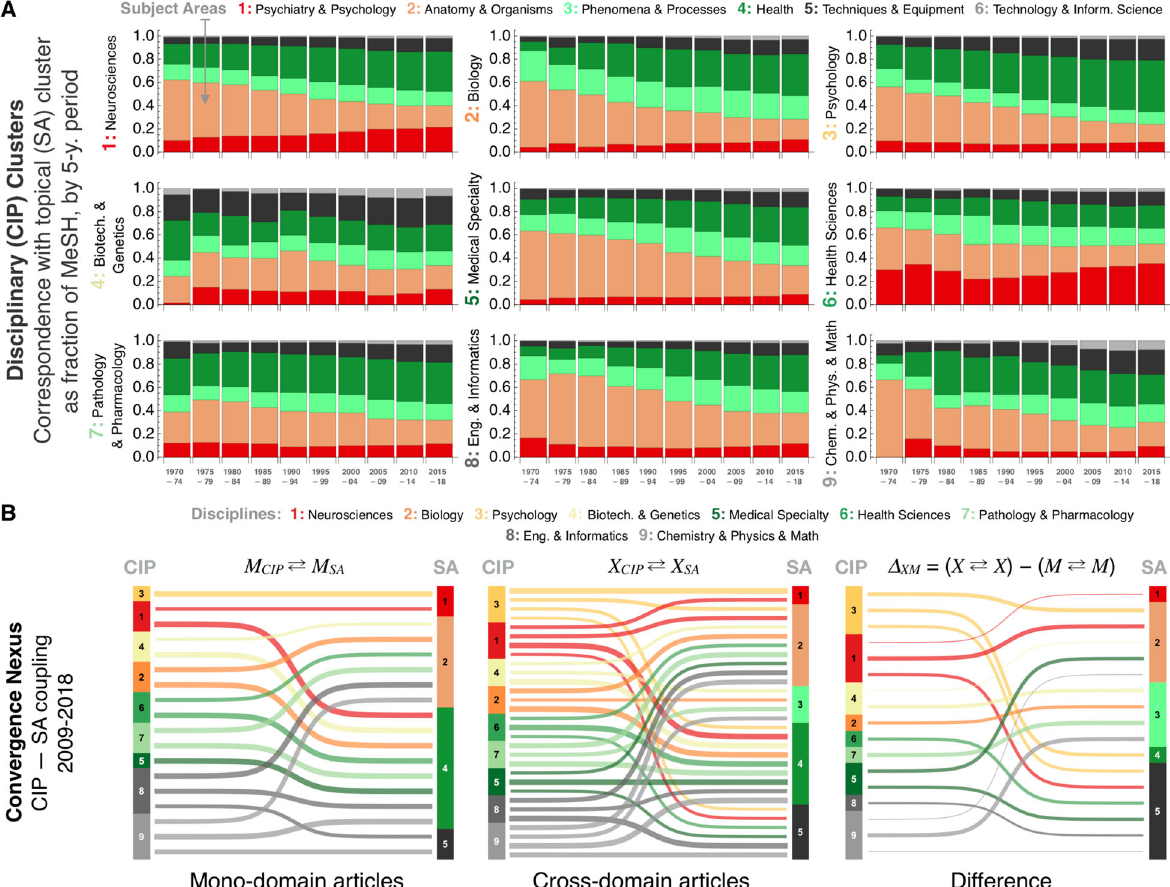
Fig. 3 Evolution of SA boundary-crossing within and across disciplinary clusters. A SA composition of HBS research within disciplinary (CIP) clusters. Each subpanel represents articles published by researchers from a given CIP cluster, showing the fraction of article-level MeSH belonging to each SA, shown over 5-year intervals across the period 1970 – 2018. The increasing prominence of SA 5 and 6 in nearly all disciplines, indicates the critical role